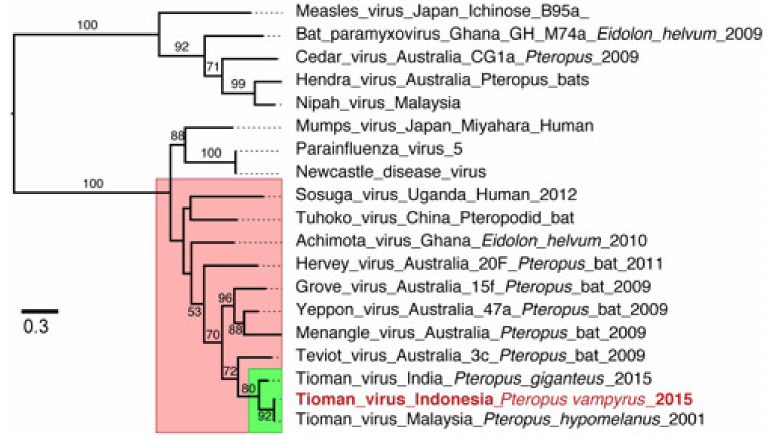
Figure 3. Maximum likelihood phylogeny of the L (polymerase) gene region of paramyxoviruses. The red box denotes sequences from members of the genus Pararubulavirus and the green box indicates Tioman virus sequences. Bootstrap values > 50% are indicated at branch nodes. The scale bar represents the nucleotide substitutions per